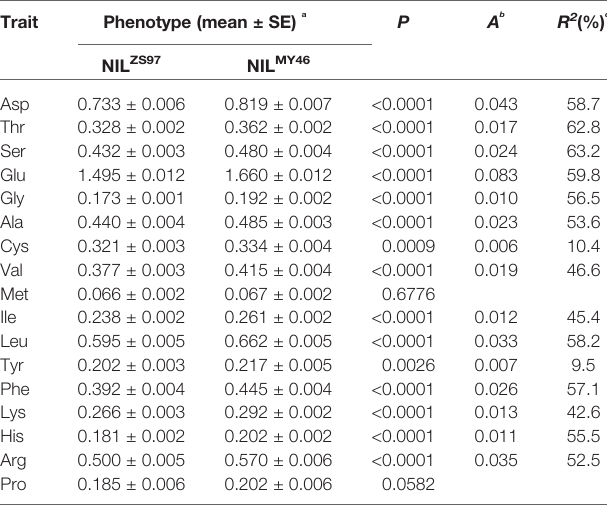
TABLE 4 | Effects of the RFT1 gene on 17 components of amino acid content (AAC) detected in the R1 population. Trait